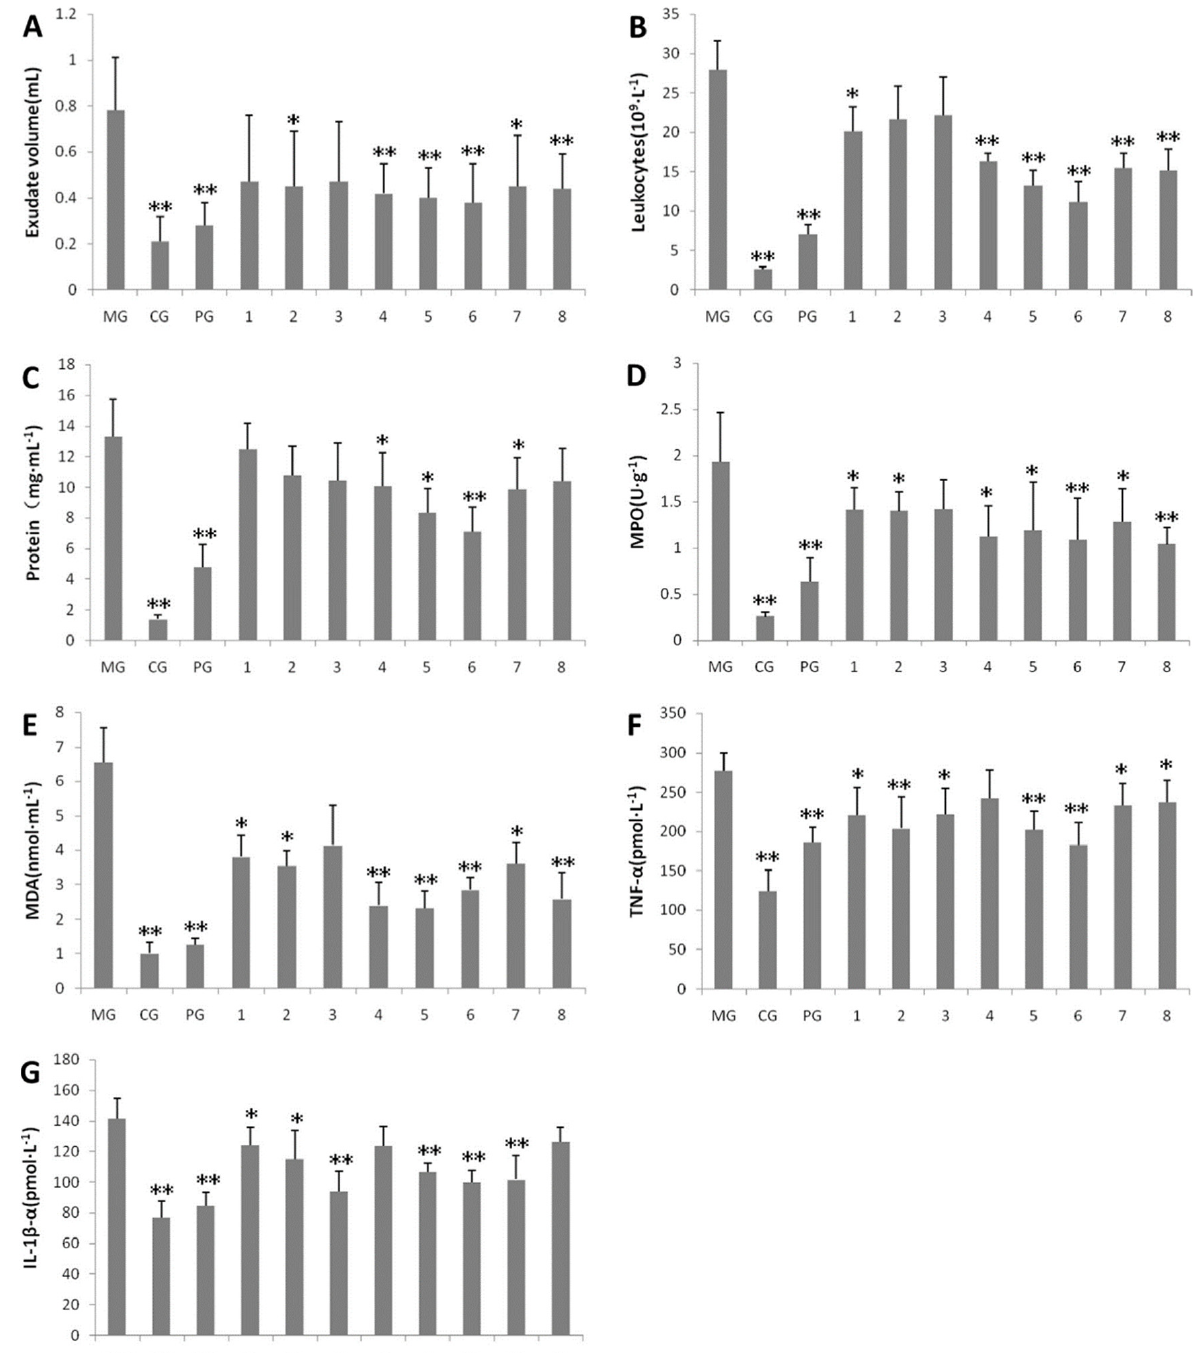
Figure 12. Anti-inflammatory effects of different volatile oils from ST on exudate volumes ( A ), leukocytes ( B ), protein levels ( C ), MPO activities ( D ), MDA contents ( E ), TNF- α levels ( F ), IL-1 β levels ( G ). Data are expressed as means ± S.E.M.; * p < 0.05, ** p < 0.01 vs. control group (From Figure 3 in [34]).